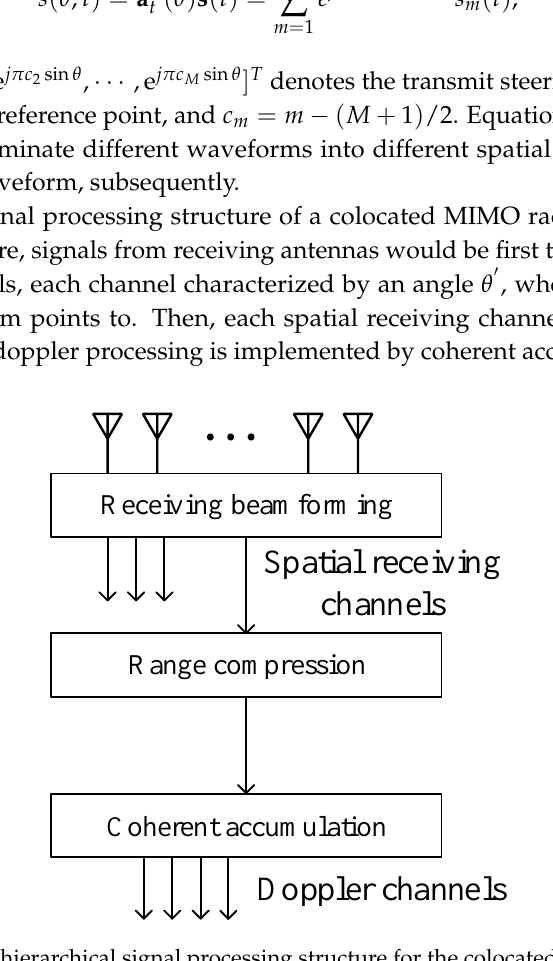
Figure 2. The hierarchical signal processing structure for the colocated MIMO